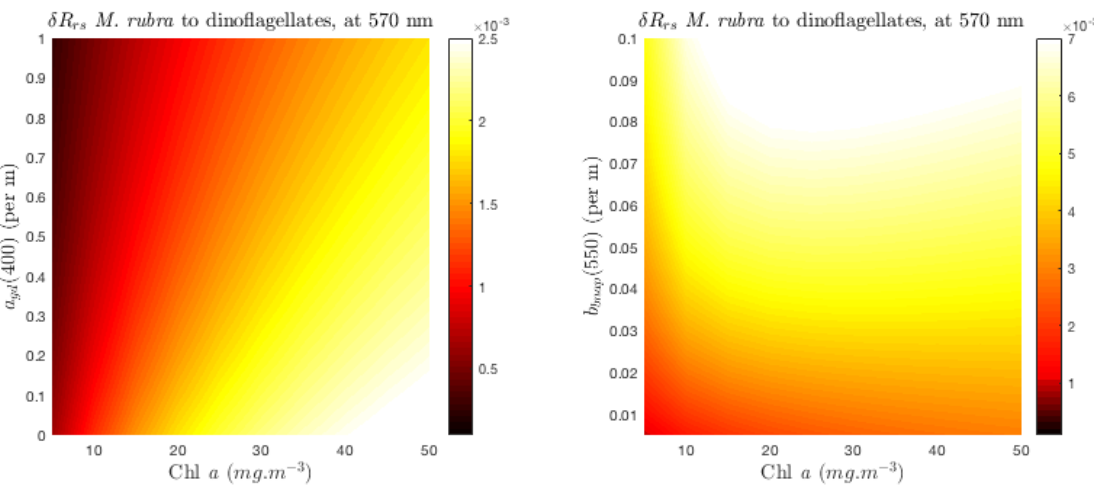
Figure 9. δ R rs sensitivity to a gd and b bnap at 570 nm, for a high biomass Myrionecta rubra -dominated assemblage, to a high biomass peridinin (carotenoid)-containing dinoflagellate-dominated